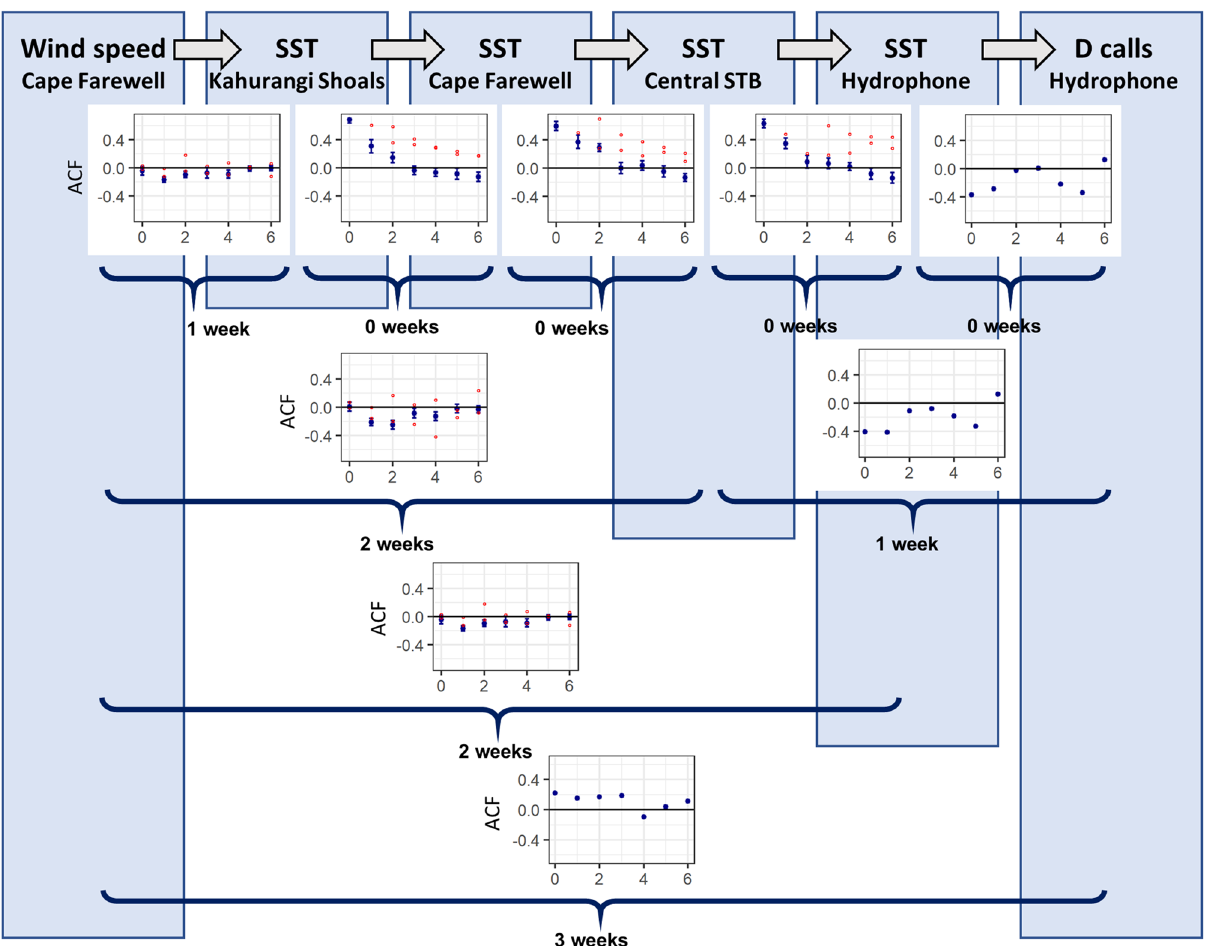
Figure 3. Results from the cross-correlation analysis along the typical path of the upwelling plume and schematic of time lags. Lag values are reported in weeks (x-axes). The autocorrelation function (ACF) measures the strength of the correlation between timeseries at that lag value, with values > 0 representing positive correlation, and values < 0 representing negative correlation (y-axes). Mean ACF was calculated at each lag step for all years between 2010 and 2018, with 2016 and 2018 partitioned a priori because of documented marine heatwave conditions. The ACF values are plotted in blue for “typical” conditions (mean ± standard error), and values from known heatwave years are plotted in red. D call density was only calculated in 2017, therefore a single ACF value is reported for each lag step.